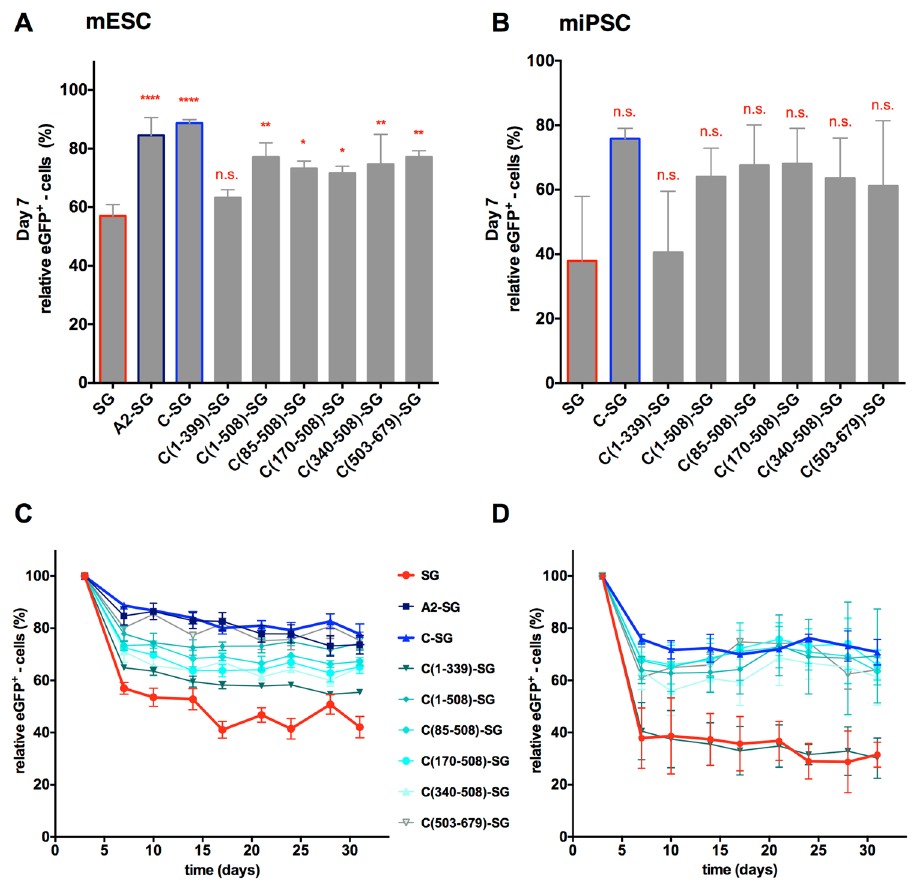
Figure 2. Activity of CBX3 subfragments in pluripotent stem cells. Murine ESCs and iPSCs were transduced with lentiviral vectors with or without the A2UCOE, the CBX3 or the CBX3 subfragments. The eGFP expression was monitored for 31 days and the relative expression (d3 = 100%) is shown for day 7 in ( A ) mESCs and ( B ) miPSCs. The time-course of relative eGFP expression for 31 days is depicted for ( C ) mESCs and ( D ) miPSCs. Activity of the subfragments was compared to the SG negative control. Data represent independent experiments n = 3; mean ± SD; * p < 0.05, ** p < 0.01, **** p < 0.0001 as determined by one-way ANOVA.